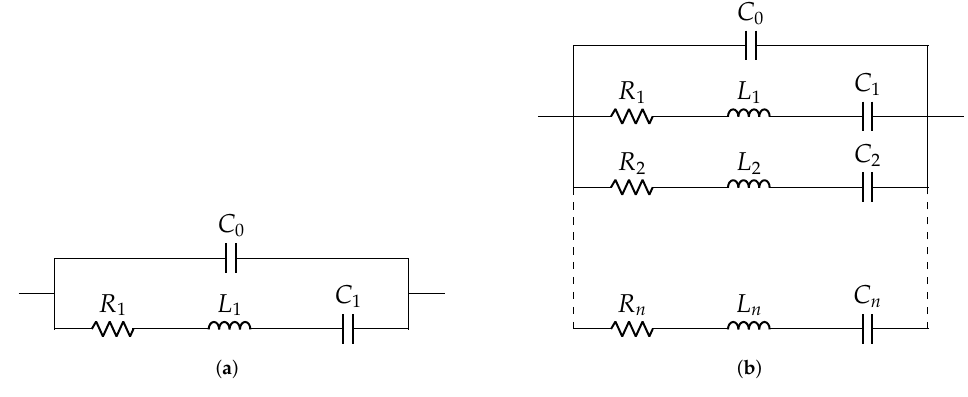
Figure 2. Van Dyke model: ( a ) unloaded case and ( b ) loaded case.